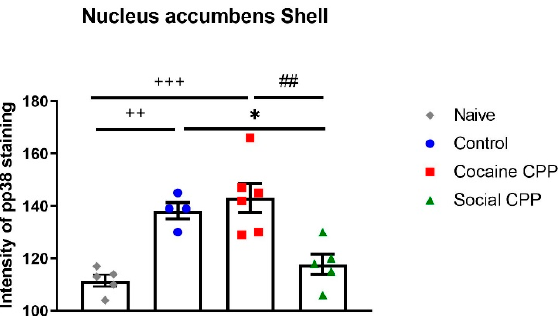
Figure 3. pp38 expression in the NAc shell 24 h after the cocaine CPP test [34]. Social interaction CPP decrease p38 MAPK activation to the levels of naïve untreated rats. Control rats receiving saline in both compartment of CPP and cocaine CPP expressing rats show similar increased levels of pp38 as compared to naïve untreated and social CPP expressing rats. Statistical test: one-way analysis of variance followed by Tukey’s post hoc test. * p < 0.05, different from saline control; ++ p < 0.01, +++ p < 0.001 different from naïve; ## p < 0.01 different from cocaine